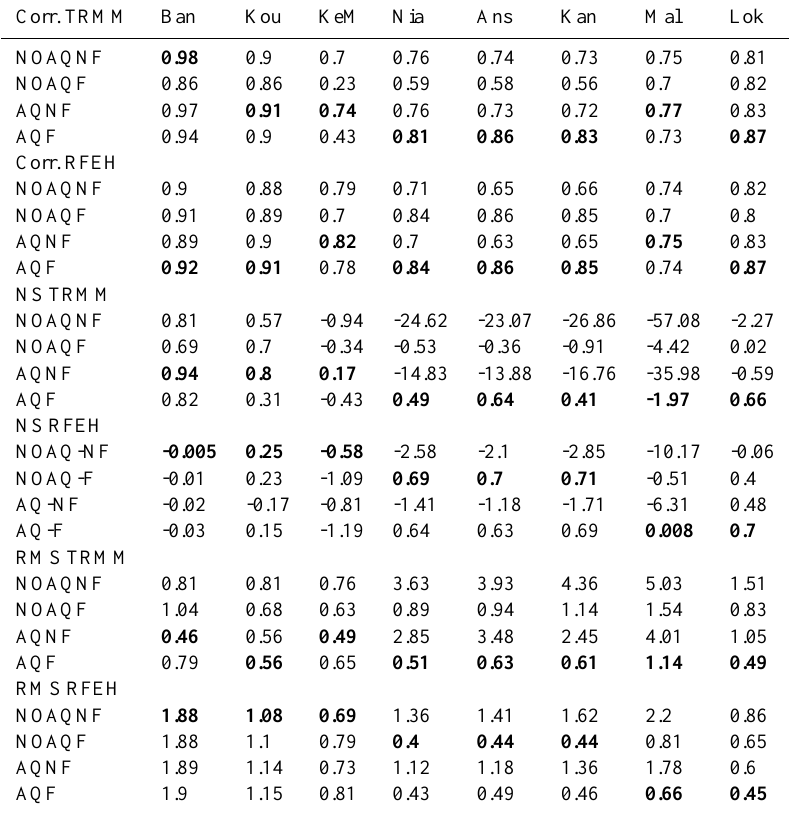
Table 3. Daily statistic scores of the discharge for the 4 configurations forced by TRMM-3B42 and RFEH from 2002 to 2004. Corr. TRMM